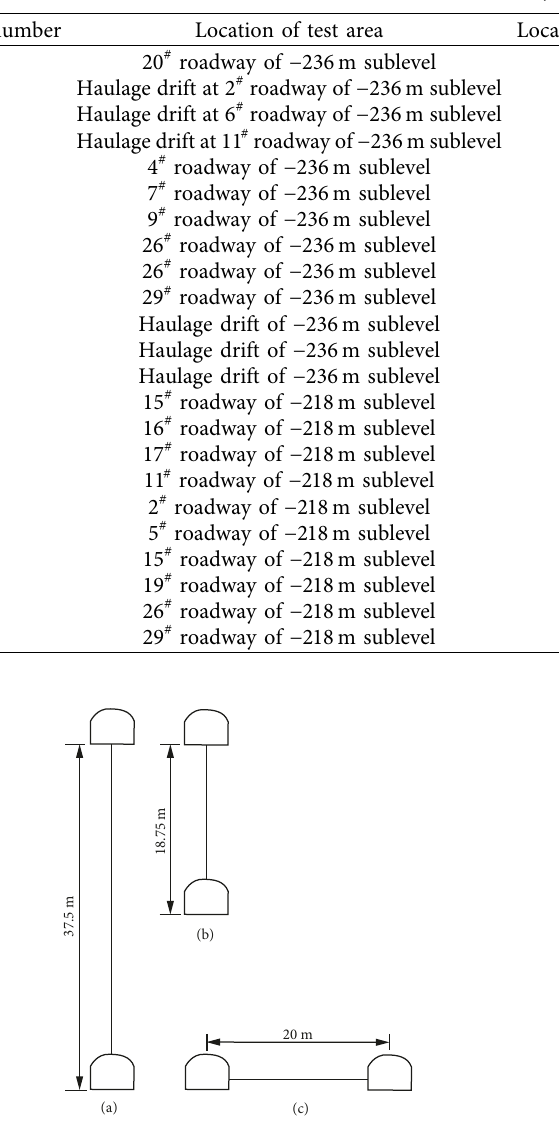
Figure 6: Position of EDZ test hole between roadways (a) location of hole No. 1. (b) location of hole No. 2–17. (c) location of hole No.